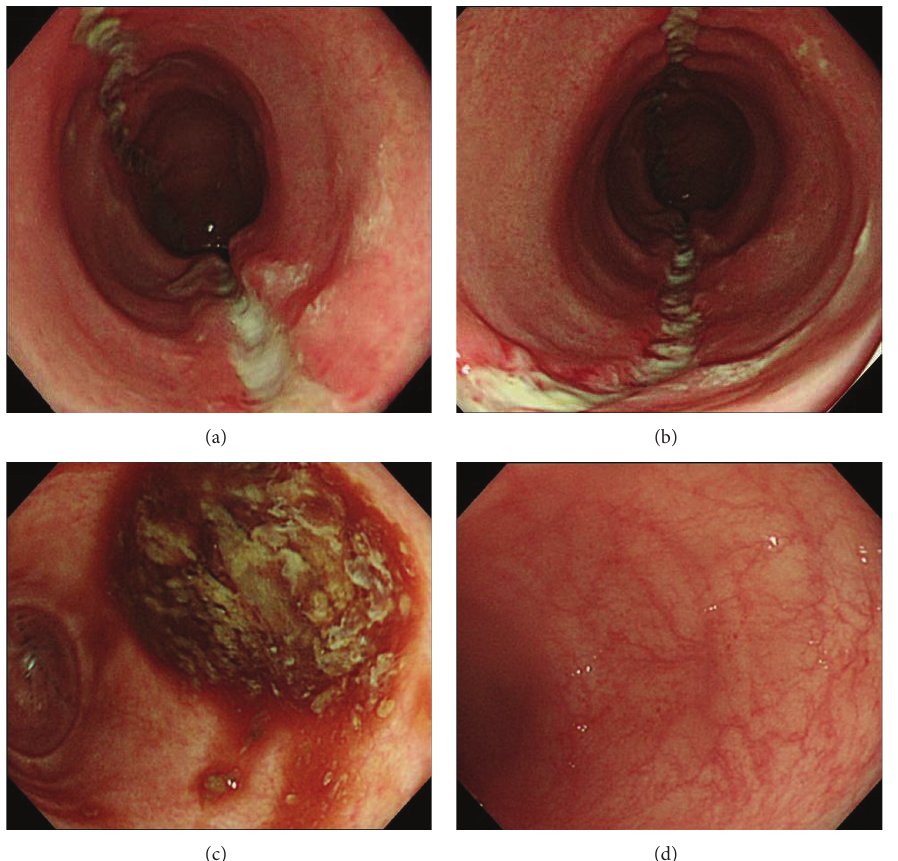
Figure 2: (a, b) Two long linear ulcers were observed in the transverse colon. Neither edema nor reddening was observed around these ulcers. (c, d) From the descending colon to the rectum, the appearances of the mucosa were normal, and the pool of watery-bloody stool was observed.